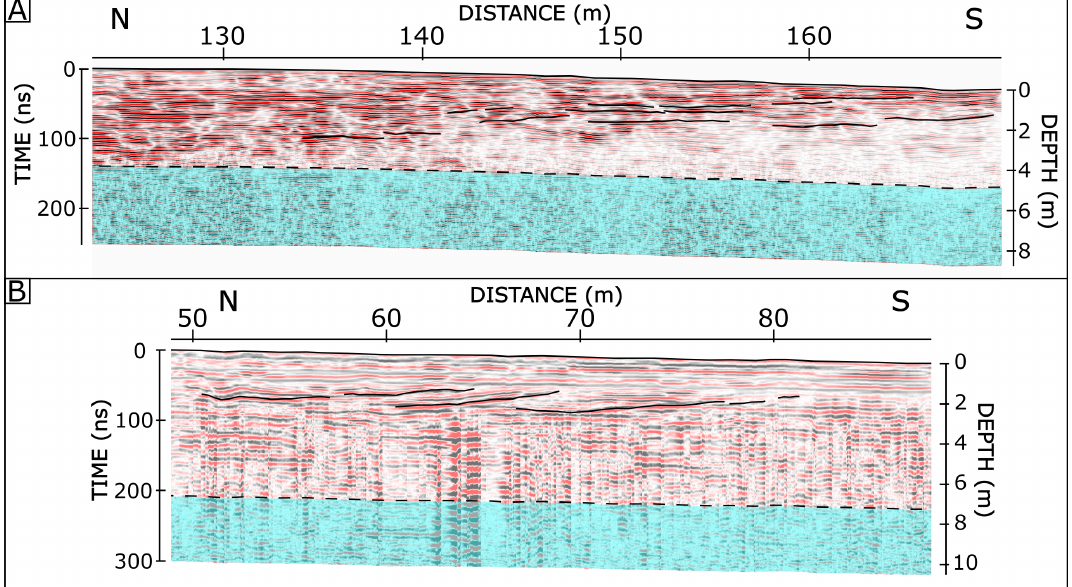
Figure 11. Processed and interpreted radargrams, recorded along the profiles g1 and g6 (see Figure 10A for location). The figure only shows the section that covers the scarp. Depths were calculated assuming a constant velocity of 0.07 m ns − 1 . ( A ): Radargram recorded along profile g1 with the 270 MHz antenna. The black lines highlight the north-dipping trend of the high amplitude reflections. The black dashed line represents the limit of penetration beyond which no interpretation was possible. ( B ): Radargram recorded along profile g6 with the 100 MHz antenna. North-dipping reflectors were detected, but the noise level is